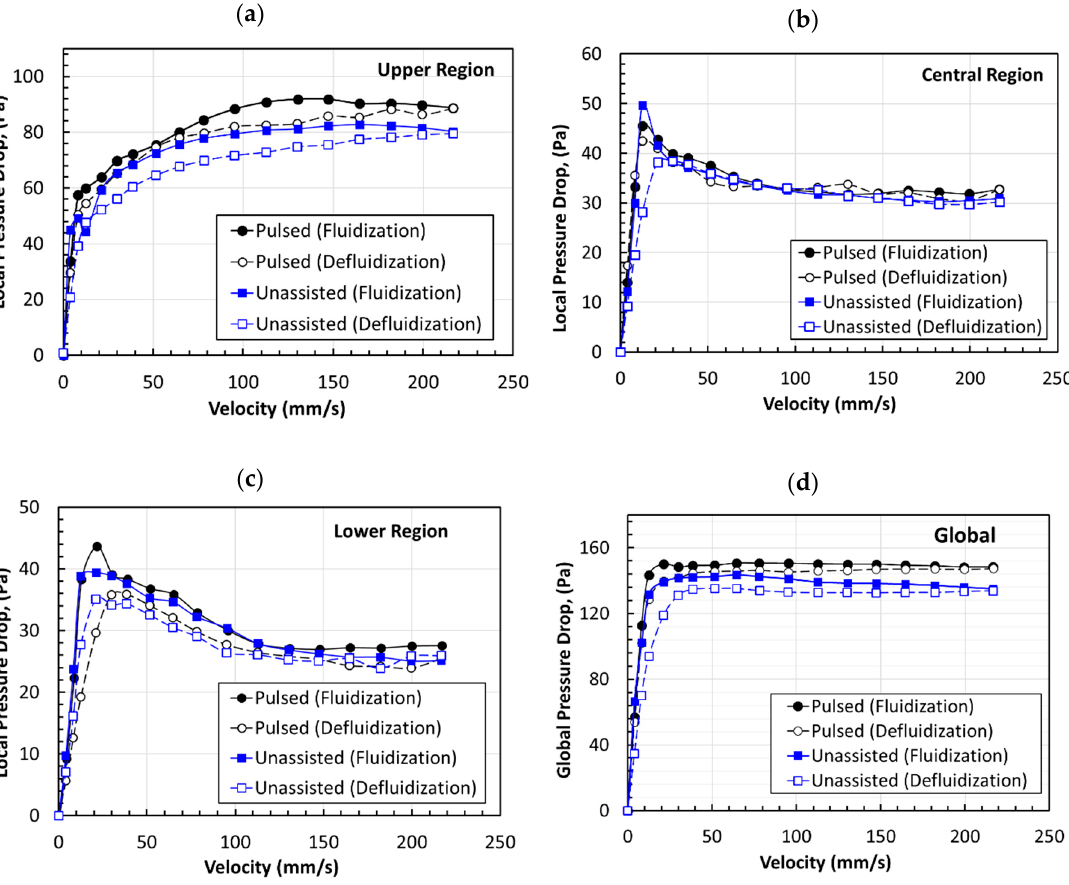
Figure 11. Dependence of the pressure drop on the velocity for different regions of the unassisted and pulsed fluidized beds during fluidization and defluidization, ( a ) upper region, ( b ) central region, ( c ) lower region, ( d ) overall bed.